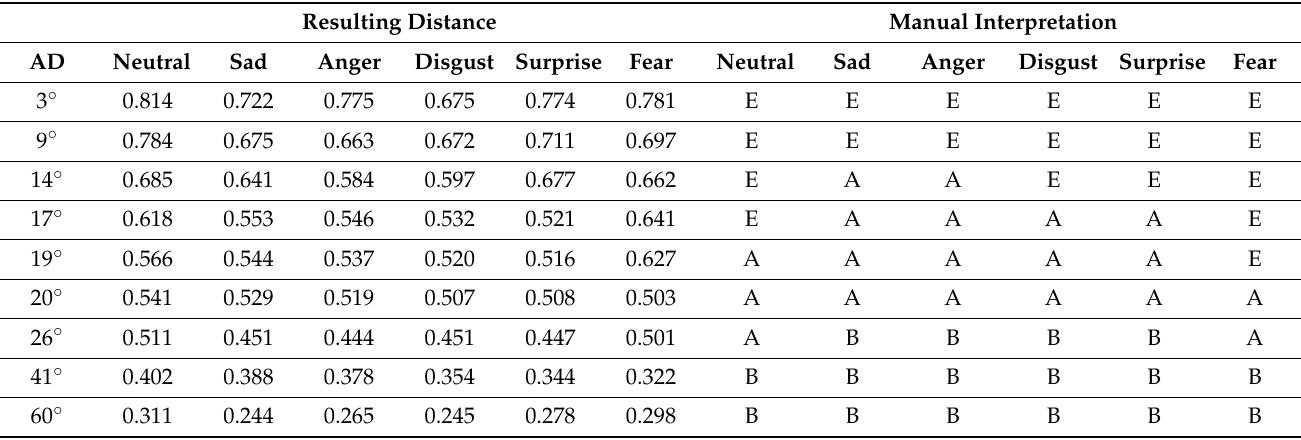
Table 5. Angular deviations choice proof.